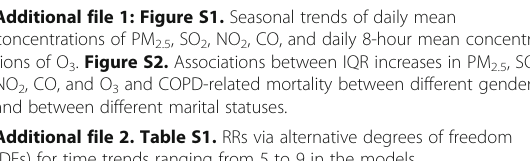
Additional file 1: Figure S1. Seasonal trends of daily mean concentrations of PM 2.5 , SO 2 , NO 2 , CO, and daily 8-hour mean concentra- tions of O 3 . Figure S2. Associations between IQR increases in PM 2.5 , SO 2 , NO 2 , CO, and O 3 and COPD-related mortality between different genders, and between different marital statuses. Additional file 2. Table S1. RRs via alternative degrees of freedom (DFs) for time trends ranging from 5 to 9 in the